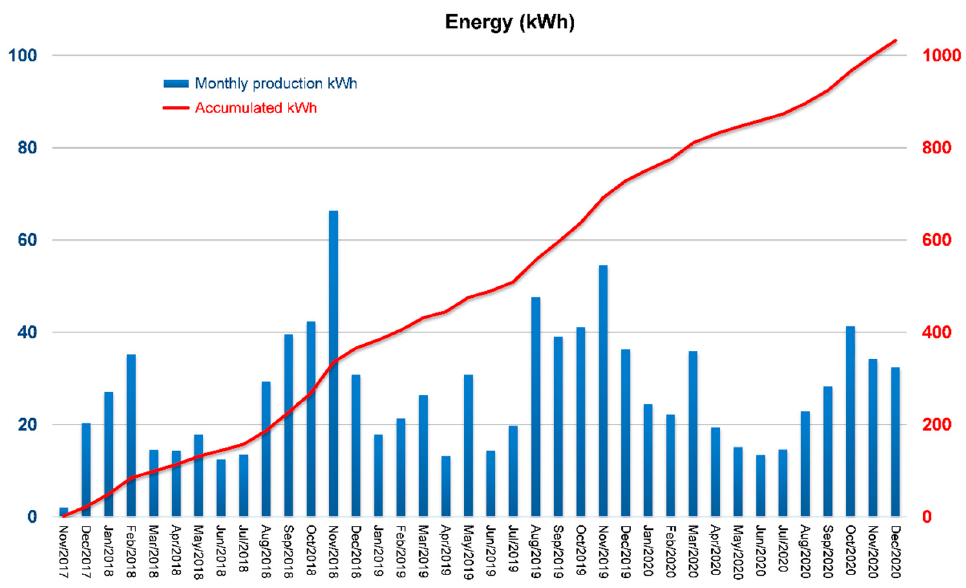
Figure 18. Small Wind Turbine energy production.